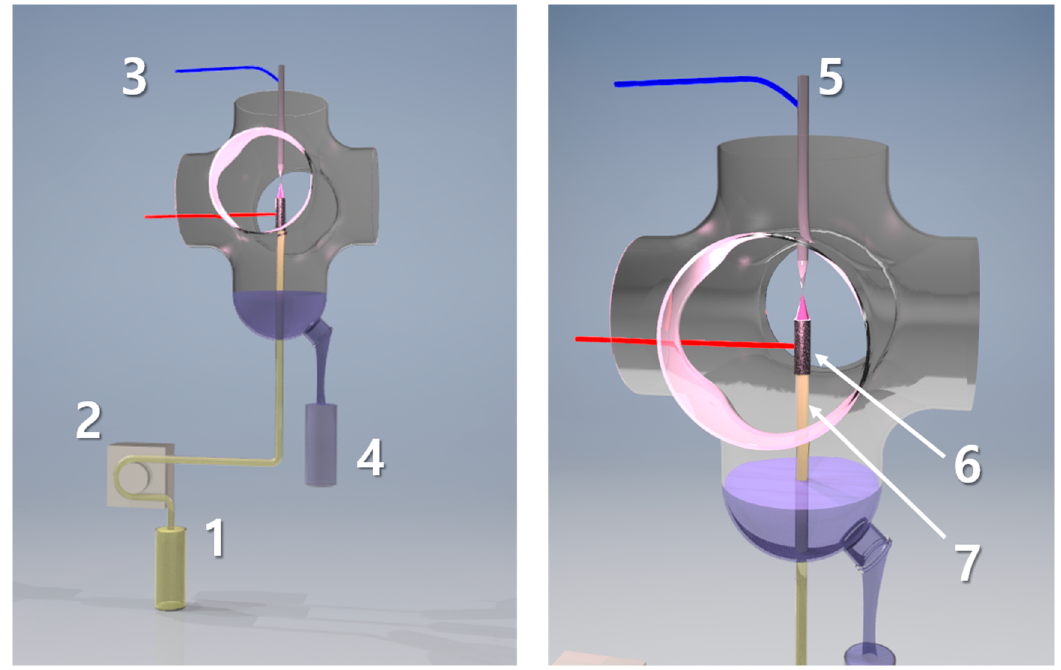
Figure 1. A continuous-flow reaction-discharge system for synthesis of poly(vinylpyrrolidone)-stabilized Pt nanoparticles (PVP-PtNPs); ( 1 ) the mixed working solution containing the PtNPs precursor and the PVP capping agent (FLA), ( 2 ) a four-channel peristaltic pump, ( 3 ) high-voltage wires, ( 4 ) a collector for the direct current atmospheric pressure glow discharge (dc-APGD)-treated solution, ( 5 ) a tungsten cathode, ( 6 ) graphite, and ( 7 ) quartz tubes.